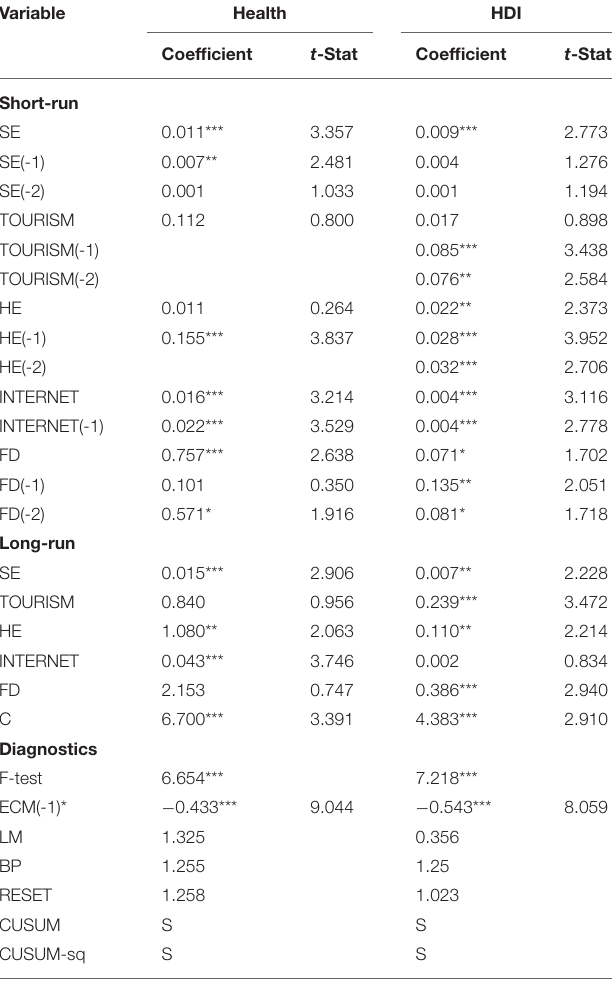
TABLE 4 | Short and long-run estimates of health and human wellbeing (Robustness).